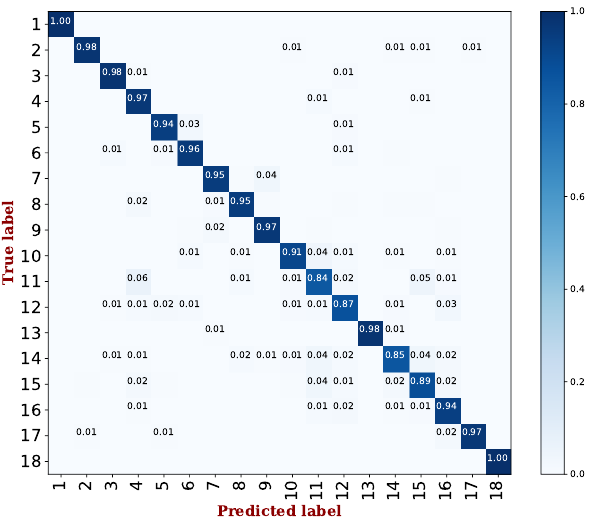
Figure 5. The confusion matrix on step identification using the AdaBoost algorithm, where each step index refers to Table 1.